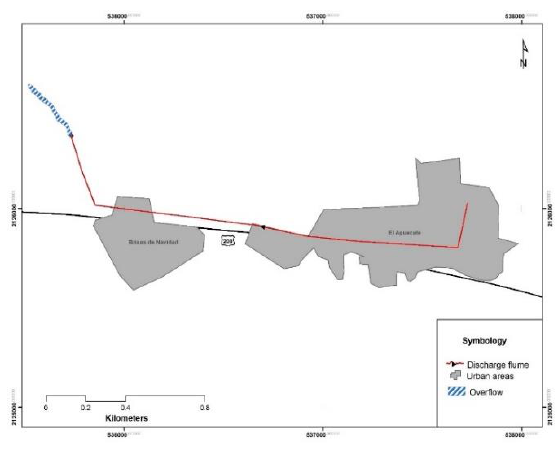
Figure 2. Location of “A” effluent.